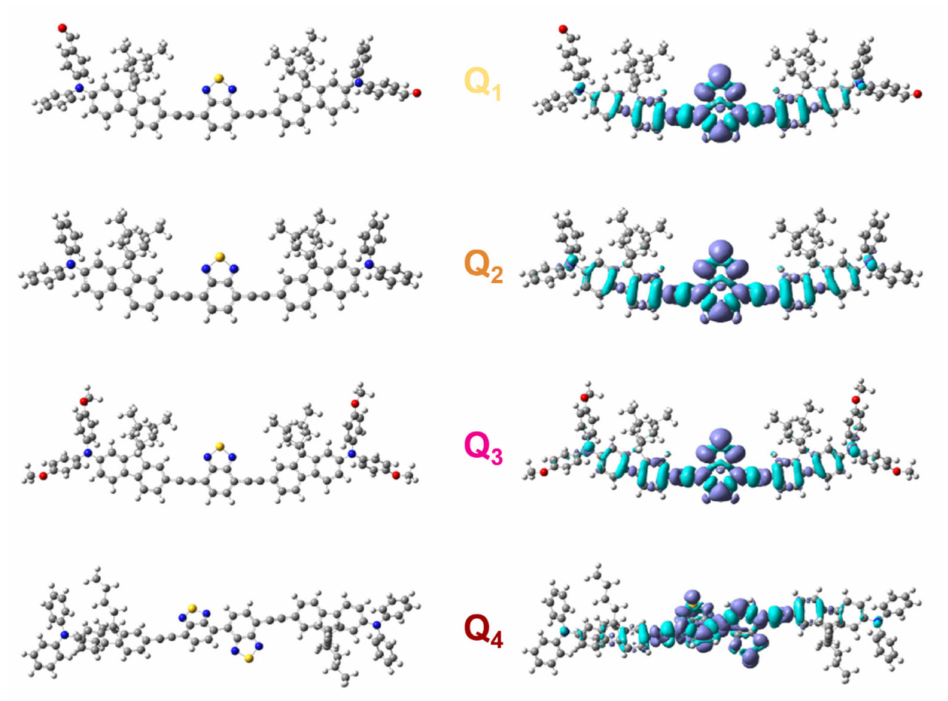
Figure 2. Ground state geometry and redistribution of the total electron density upon the S 0 → S 1 transition for dyes Q 1 – Q 4 . Dark (light) blue lobes in density maps are associated with areas of increasing (decreasing)